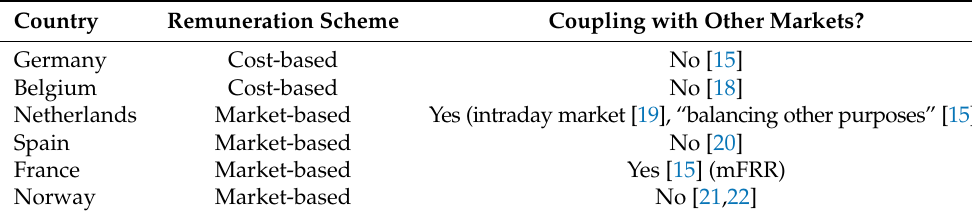
Table 1. Remuneration for redispatch in different countries. Country Remuneration Scheme Coupling with Other